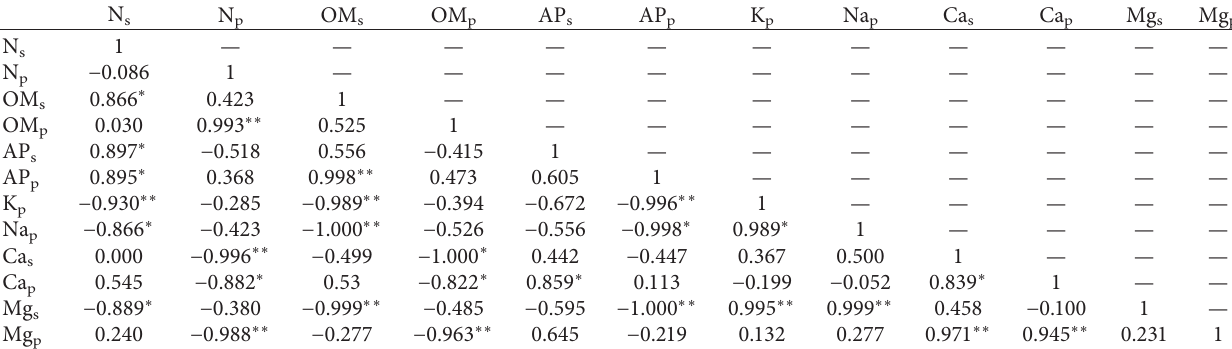
Table 6: Correlation between soil and plant physicochemical